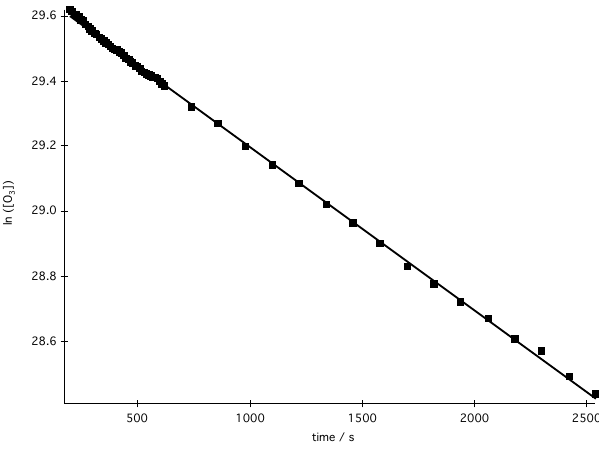
Figure 3 : Temporal plot of ozone decay to yield k ′ , with an initial [ethene] of 10.5 ppm.